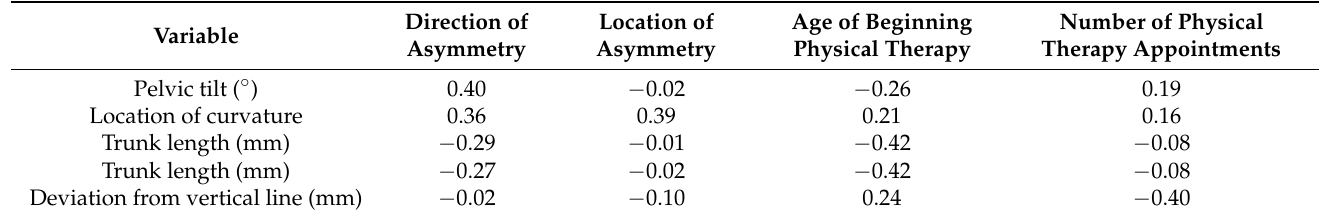
Table 5. The results of correlation analysis between body posture and the features of children’s asymmetry in the study group.